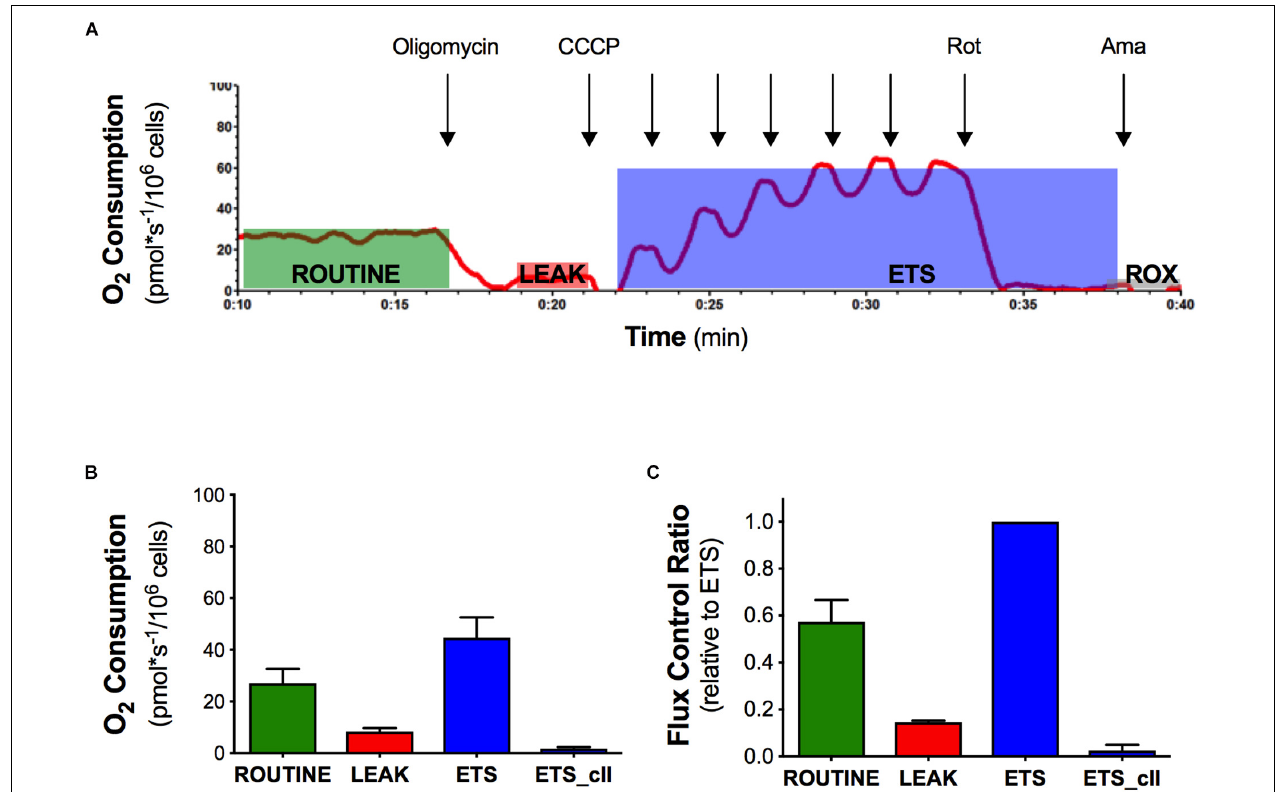
FIGURE 1 | Oxygen consumption and flux control ratios of the naïve NSC-34 intact cells obtained by high resolution respirometry. (A) Rate of oxygen consumption of intact naïve NSC-34 measured at 37 ◦ C in DMEM in the following states: the ROUTINE respiration sustained by pyruvate, malate, and endogenous substrates; the LEAK respiration obtained following addition of olygomicin; the maximal uncoupled ETS capacity (addition of CCCP) and the ROX, residual oxygen consumption following addition of the inhibitor of complex III antimycin A. The red line represent the rate of oxygen consumption normalized per number of cells. (B) Quantitative analysis of data of oxygen consumption in the different respiratory states. (C) Flux control ratios, data normalized to the ETS. Data in (B,C) are represented as mean ± SD, n =